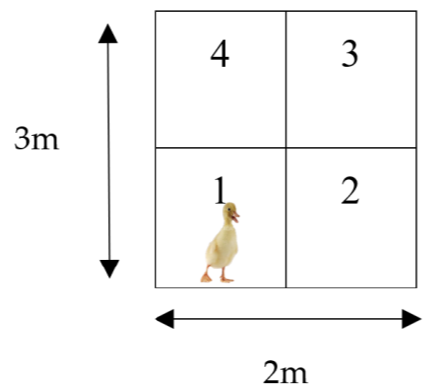
Figure 1. Experimental set-up for the 5 minutes open-field test.